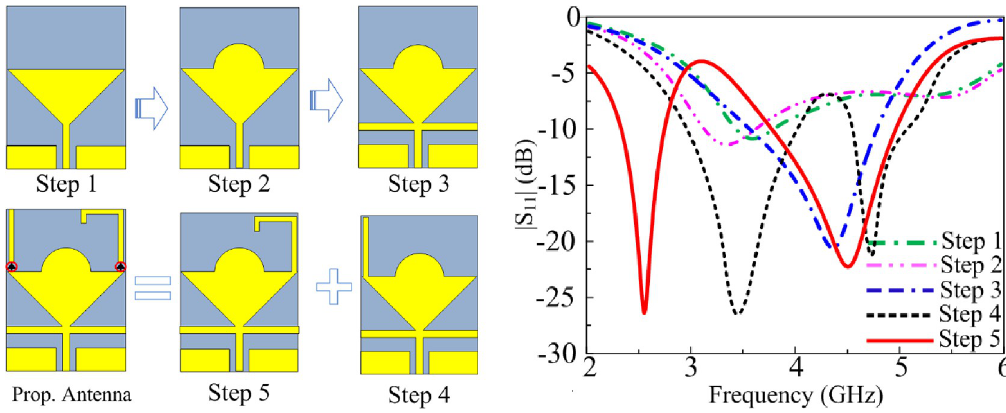
Fig 2. (a) Design evolution of proposed antenna, and (b) impact of the various steps on antenna’s |S 11